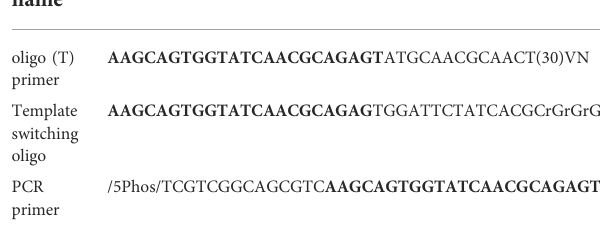
TABLE 1 Primers used in this study. The common sequence across all primers is shaded in bold.